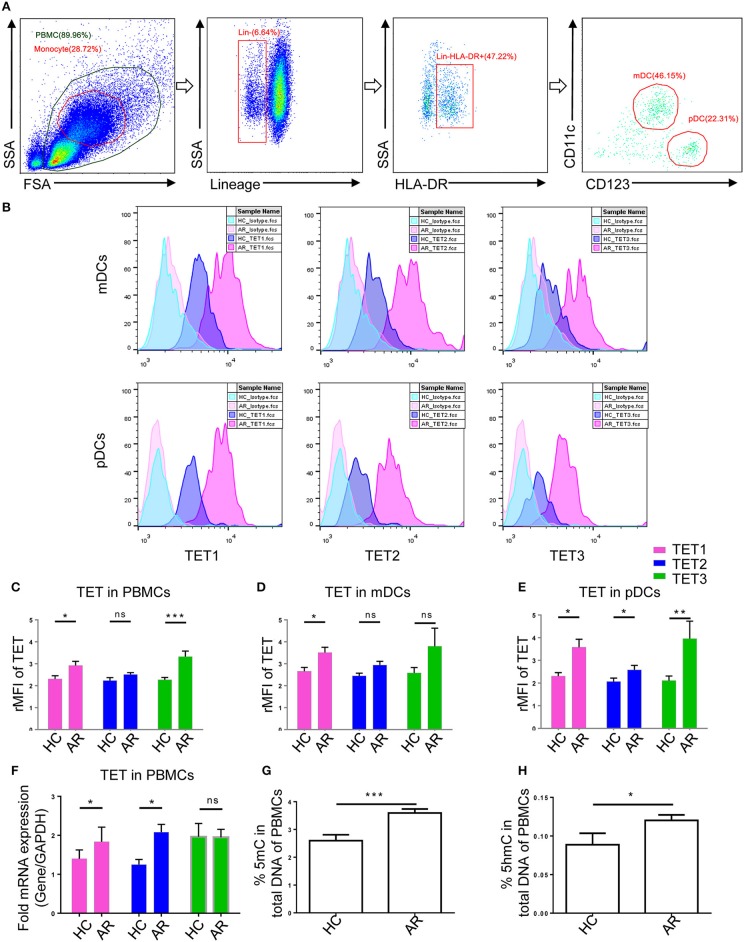
Ten-Eleven Translocation (TET1, TET2, and TET3) family enzymes are associated with allergic rhinitis (AR) in human patients. (A) Representative gating strategies of flow cytometry analyses for peripheral blood mononuclear cells (PBMCs) and Lin−HLA-DR+CD11c+CD123− myeloid DCs (mDCs) and Lin−HLA-DR+CD11c− CD123+ plasmacytoid DCs (pDCs). (B) Representative histogram plots of TET1, TET2, and TET3 expression in mDCs and pDCs. (C–E) Expression of TET enzymes in PBMCs (C), mDCs (D), and pDCs (E) in healthy controls (HC) and AR patients. The relative median fluorescence intensity (rMFI) was defined as the median fluorescence intensity (MFI) of TET divided by the MFI of Isotype. (F) TET family mRNA expression levels in PBMCs of healthy controls and AR patients. (G,H) Global 5mC (G) and 5hmC (H) levels in PBMCs of healthy controls and AR patients. Values were presented as means ± SEMs. Mann-Whitney tests were conducted. *p < 0.05, **
p < 0.01, and ***
p < 0.001.